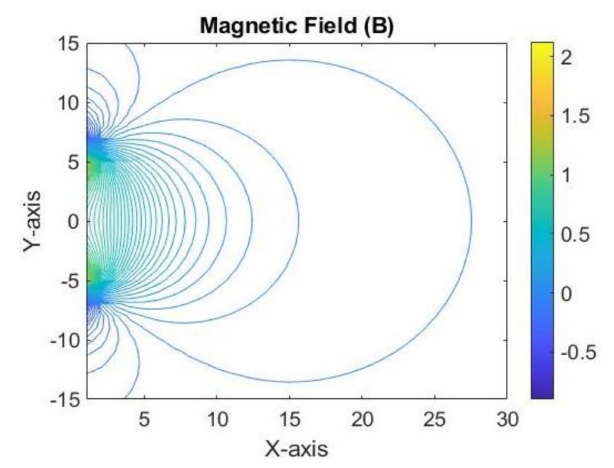
Figure 2. Flux lines density of the magnetic field calculated at xy plane, coil radius of Transmitter Tx and Receiver Rx = 6 m, Turns of the coil are N = 25, Current I = 10 A.